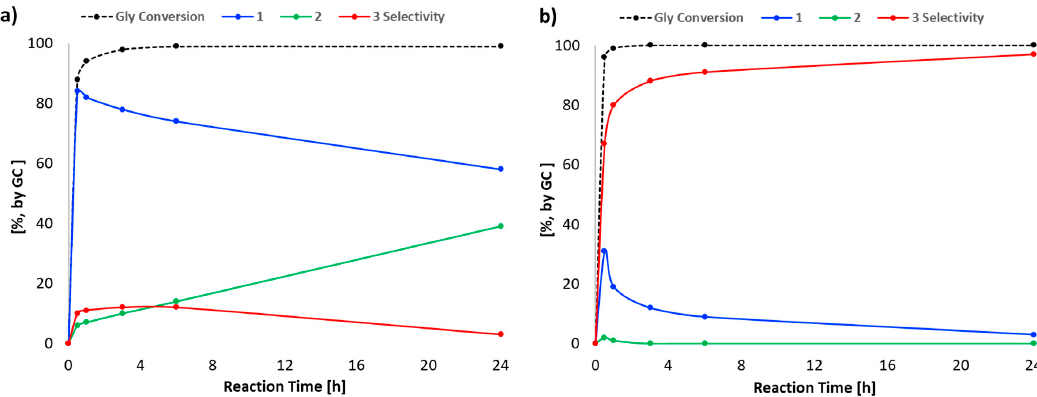
Figure 5. Conversion of Gly and products selectivity for the catalyst-free reaction between Gly and HC(OMe) 3. Reaction conditions: Gly [5.43 mmol] and HC(OMe) 3 with Q = 1 ( a ) or Q = 10 ( b ) at 90 °C.